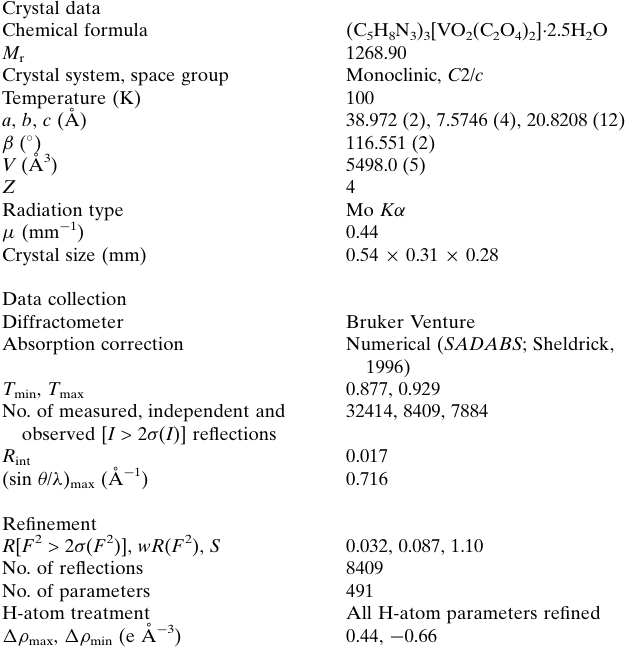
Table 2 Experimental